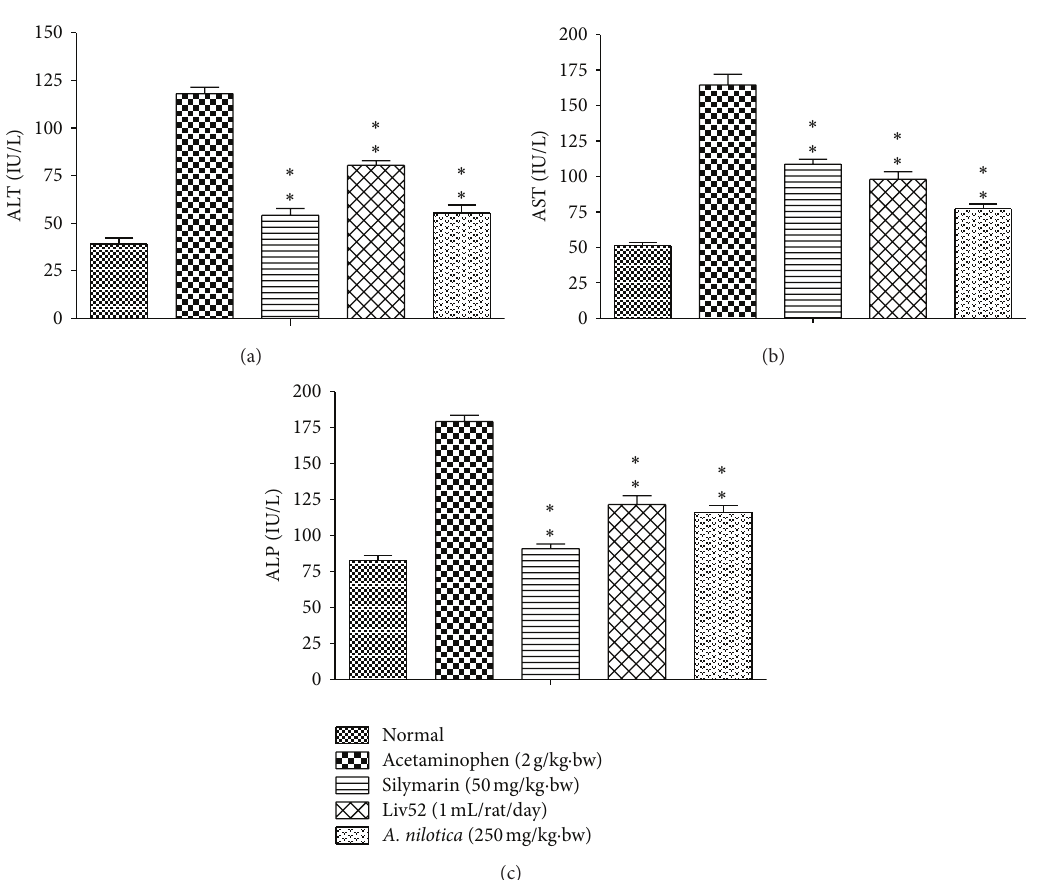
Figure 1: Effect of the methanolic extract of A. nilotica (250mg/kg ⋅ bw) on ALT, AST, and ALP in acetaminophen-treated animals. Values shown are the means ( ± SD)—expressed in IU/L of 6 mice/treatment group. Values are significantly different from acetaminophen-treated (nonextract-treated) control, ( ∗ 𝑃 < 0.05 , ∗∗ 𝑃 < 0.01 ).